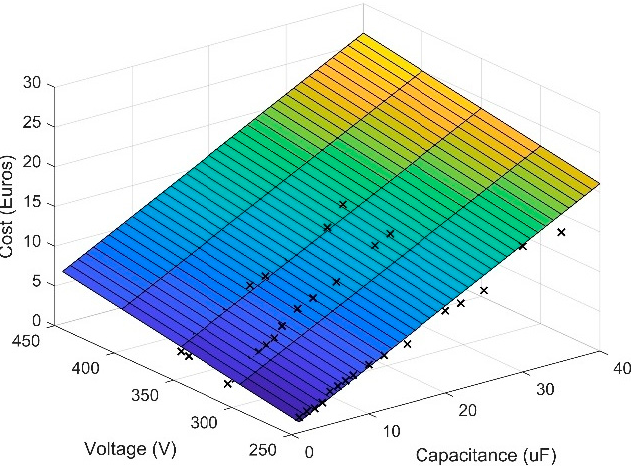
Figure 13. Estimation of the cost of a film capacitor.